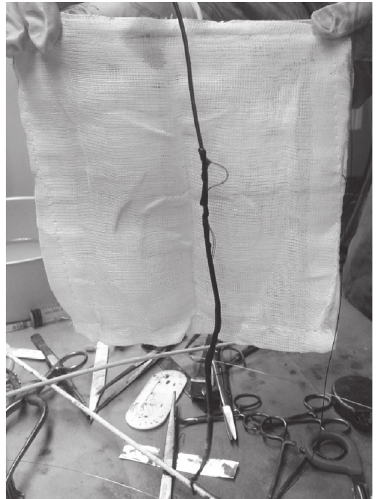
Figure 2: Extracted externalized Riata